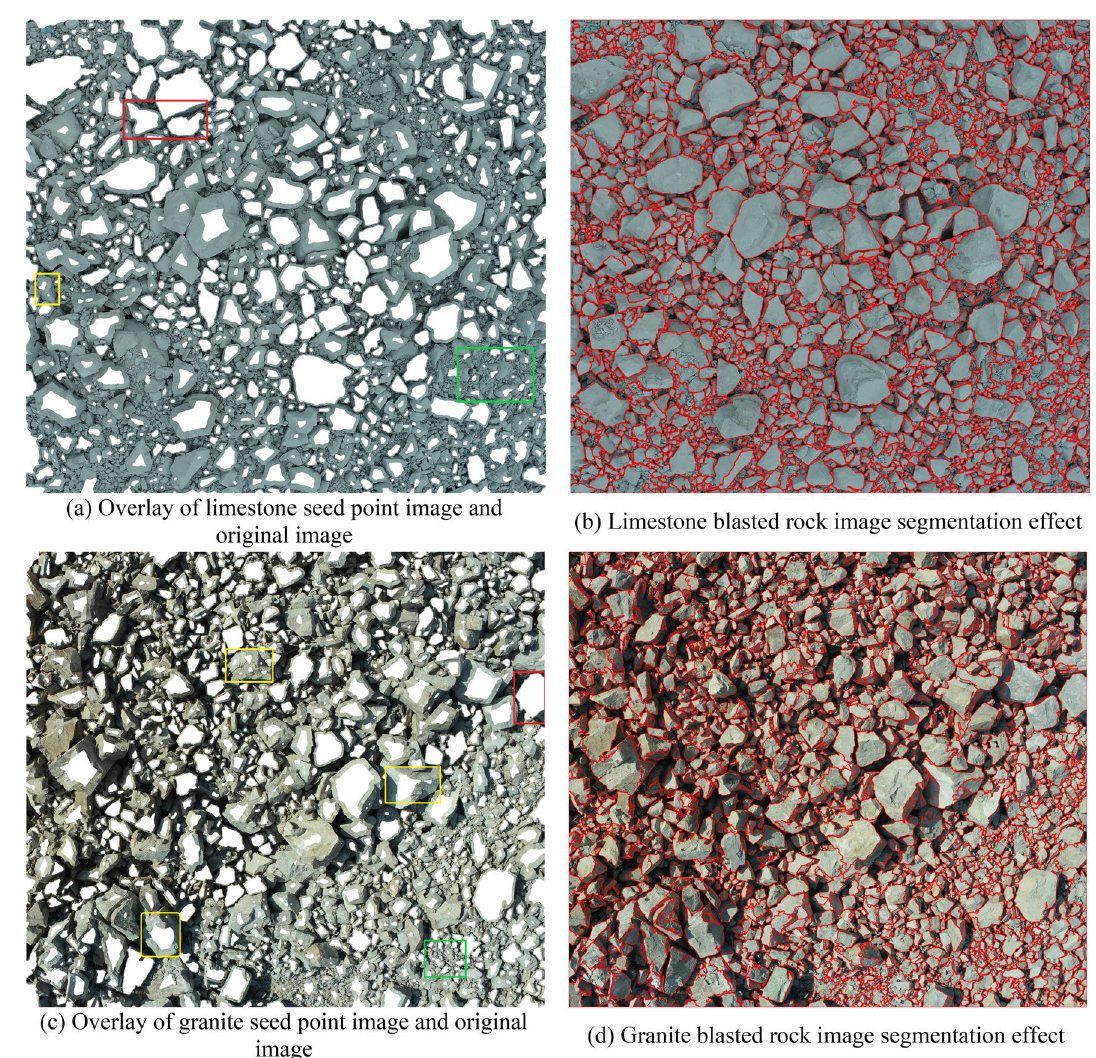
Figure 18. Blasted rock seed point marking effect and segmentation effect for a solidity threshold of